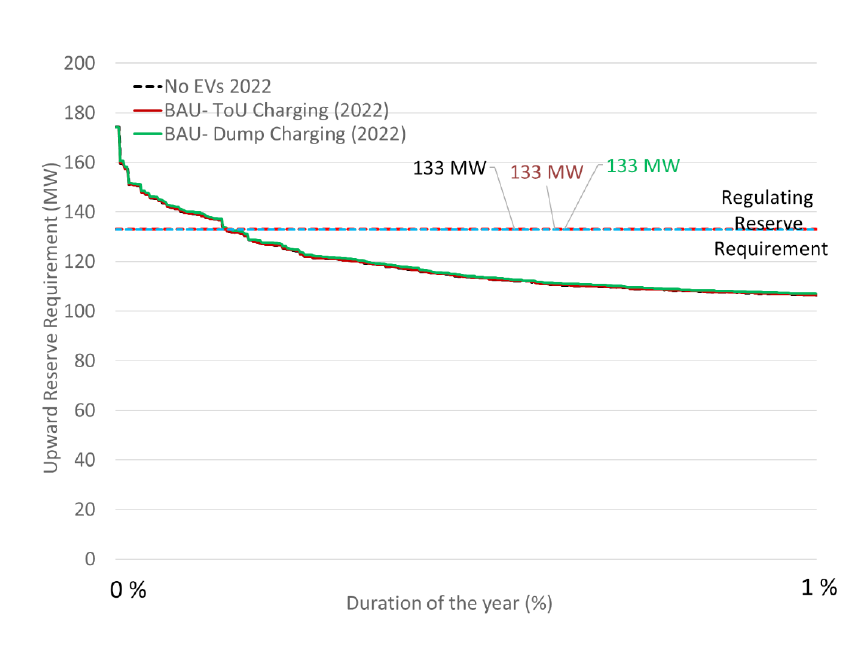
Figure 8: The largest 1% of upward variation of load in BAU